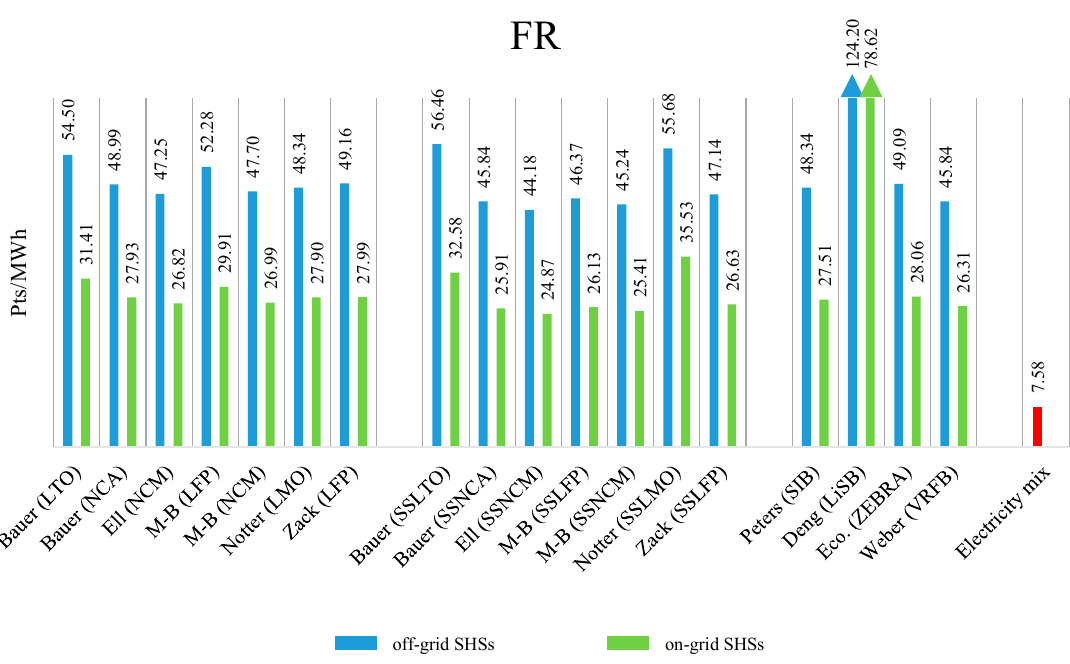
Figure 6. LCA impact values of SHSs in Spain as single scores. Energies 2020 , 13 , x FOR PEER REVIEW